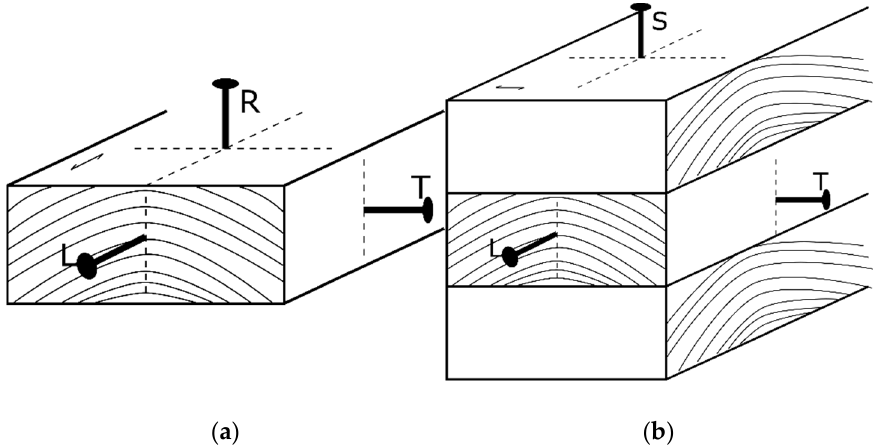
Figure 1. ( a ) Withdrawal directions in sawn timber: (L) parallel to the grain or longitudinal, (R) perpendicular to the grain in radial direction, (T) perpendicular to the grain in tangential direction (side face). ( b ) Loading direction in CLT: (L) longitudinal edge loading (parallel to grain), (T) tangential edge loading (perpendicular to grain), (S) perpendicular to the surface loading.